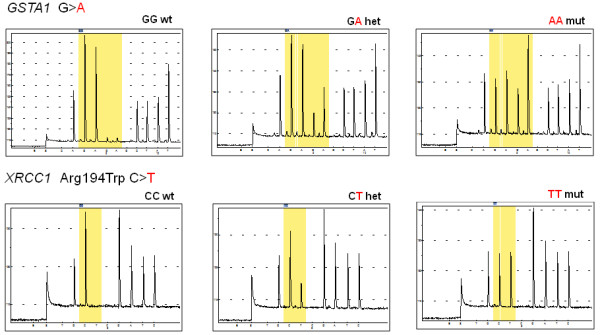
Typical raw data obtained using Pyrosequencing instruments for GSTA1 and XRCC1 Arg194Trp polymorphisms. Note: the yellow area indicates the resulting genotypes of GSTA1 and XRCC1 Arg194Trp.